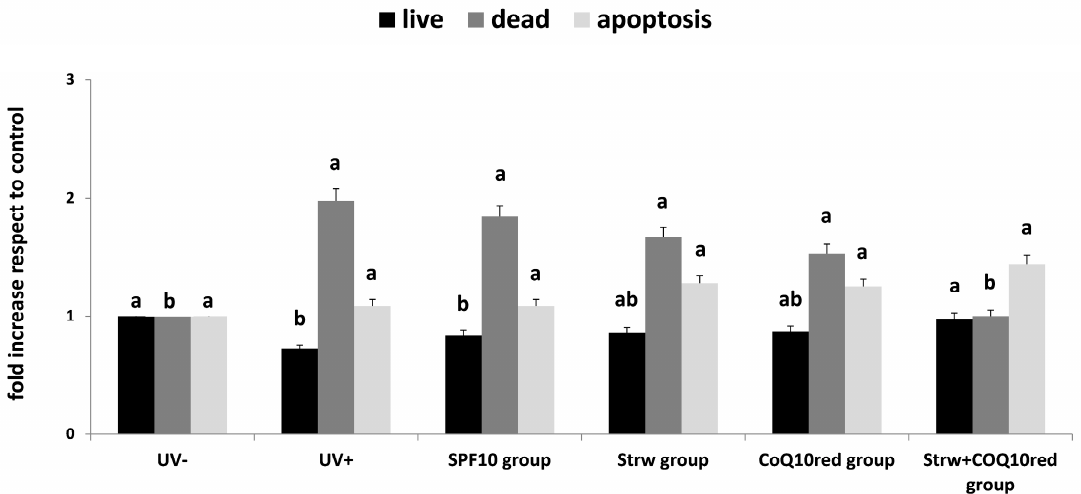
Figure 2. Live, dead, and apoptosis levels in human dermal fibroblast (HDF) cells irradiated with ultraviolet A (UVA, 275 kJ/m 2 ) radiation (UV+) or not irradiated (UV − ), after 1 h of exposure. HDF were screened with different formulations as explained in the text. Data are expressed mean values ± standard deviation (SD). Columns with different superscript letters are significantly different ( p < 0.05).